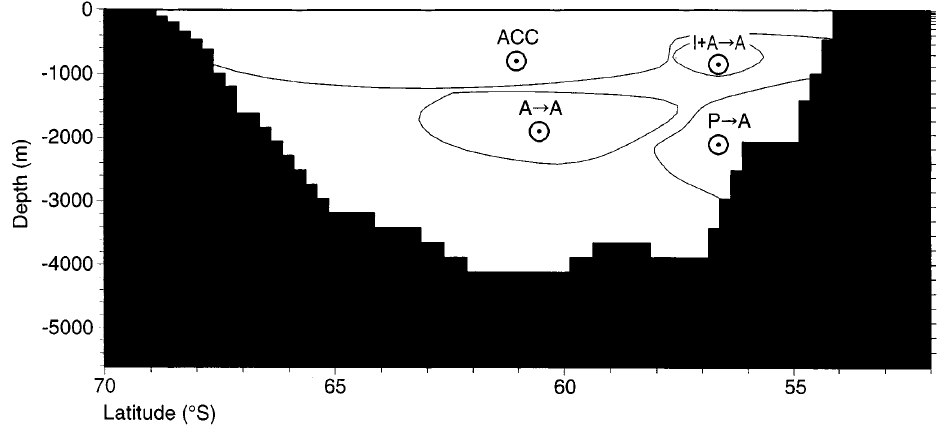
Fig. 12. A schematic meridional section along 71 (cid:14) W (Drake pas- sage) between Antarctica at 69 (cid:14) S and South America at 53 (cid:14) S. The arrowhead and arrowtail symbols indicate water flowing eastwards and